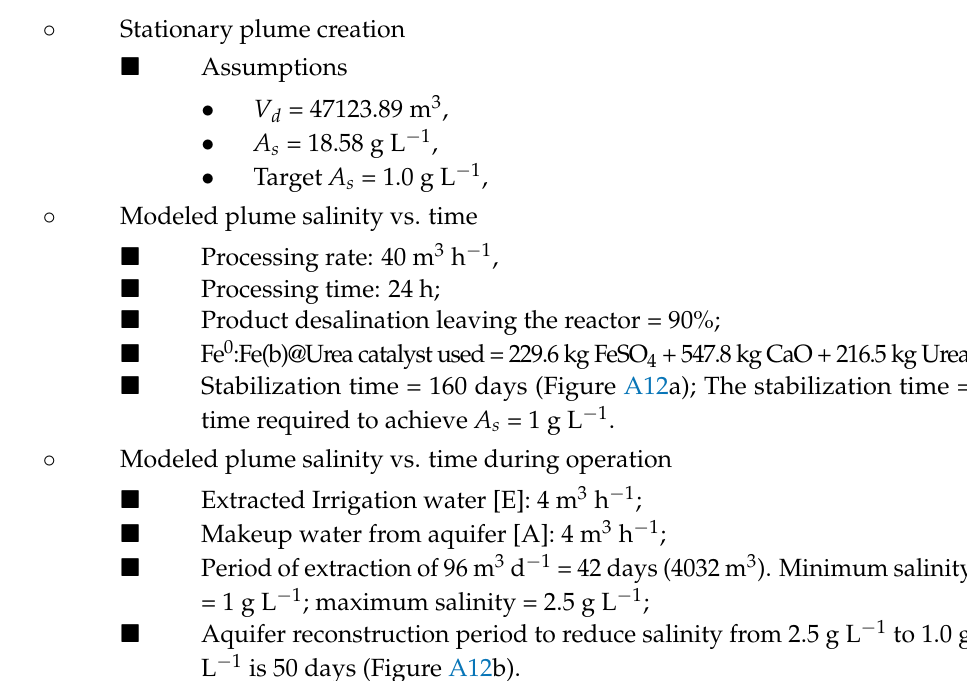
Figure A11. Modeled stationary plume. SiO 2 @Fe(b)@Urea polymer catalyst: ( a ) time required to re- duce the plume salinity. ( b ) Salinity of irrigation water versus time, and aquifer recharge time.